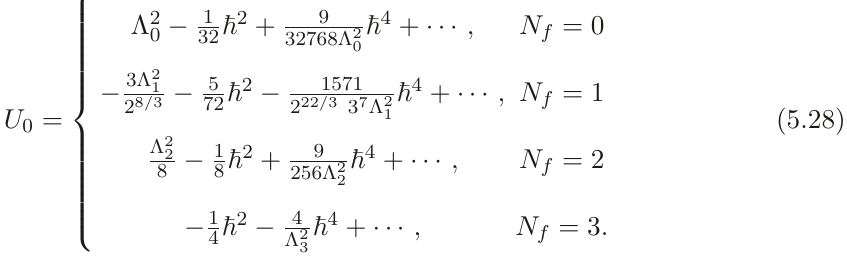
(2 k,n ) ( N f = 2 , 3) are listed in the table 3 DN f F